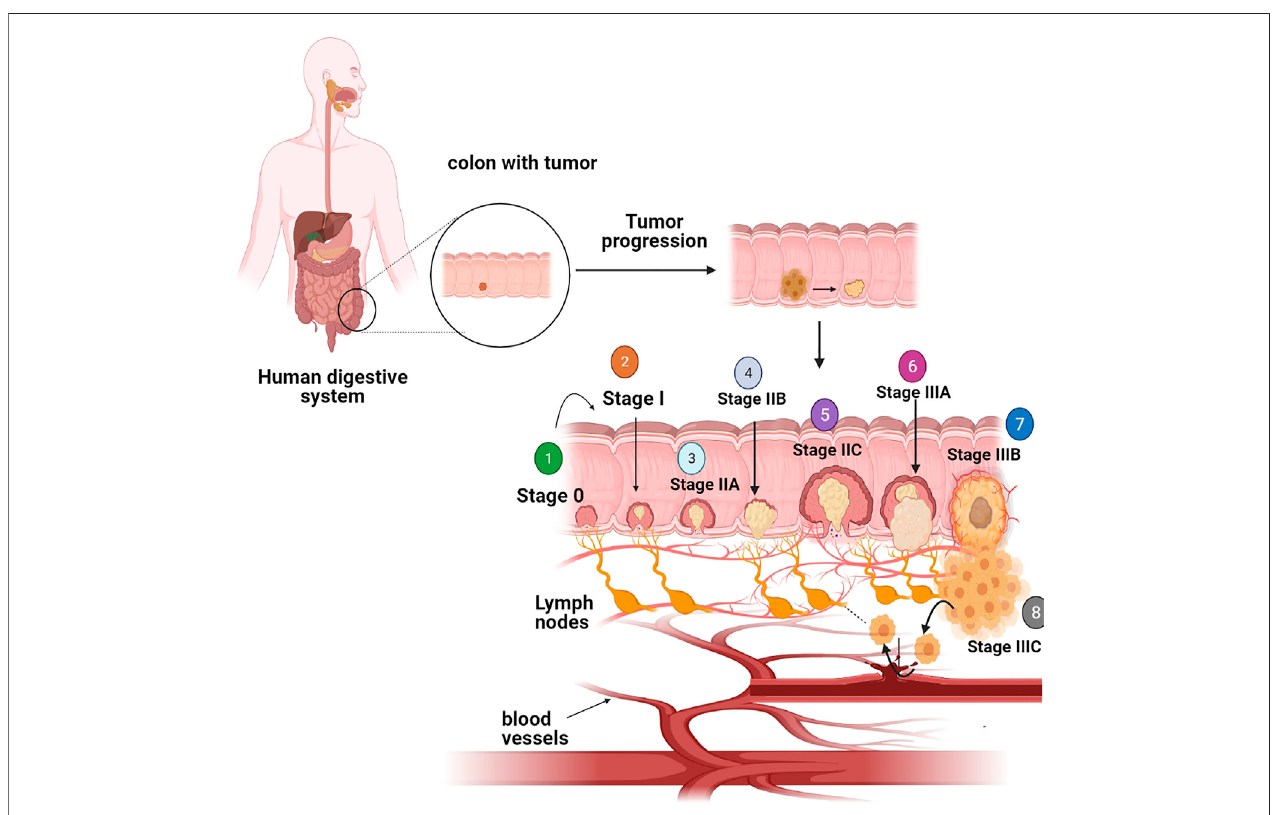
FIGURE 1 | Schematic representation of different stages of